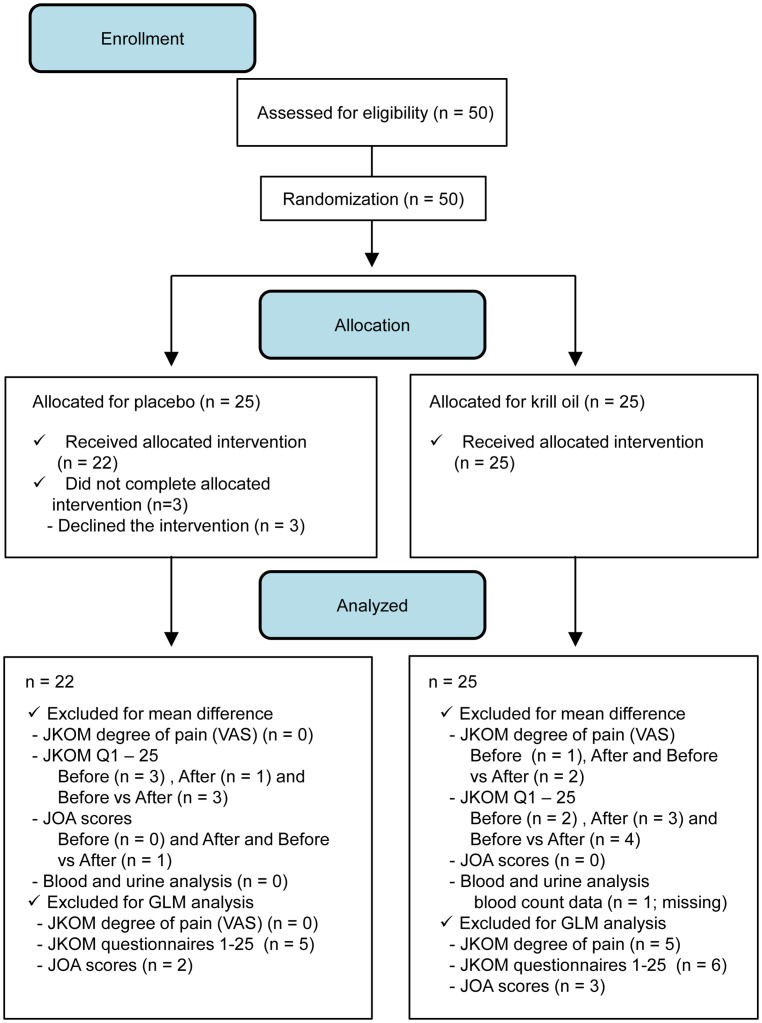
Participant flow.